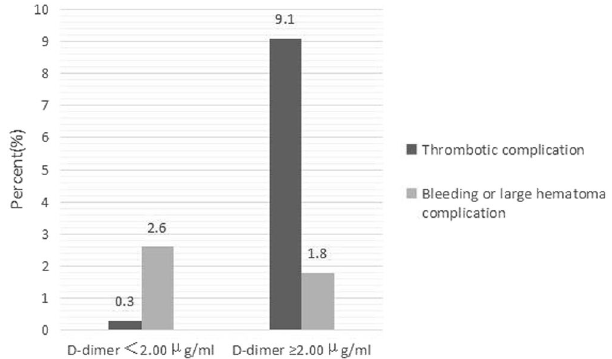
Figure 1. D-dimer and thrombotic or bleeding complications.